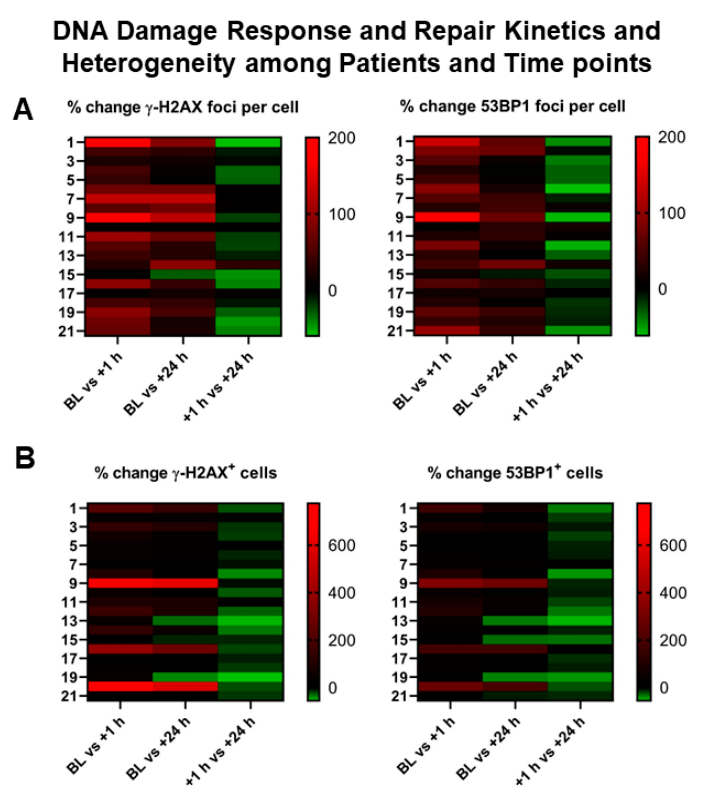
Figure 3. Heterogeneity of DNA damage response in patients receiving PRRT. ( A , B ) Graphical illustration (heat map) of inter-individual heterogeneity in DSB markers and their evolution over time, depicted as a heat map ranging from negative % change (green) to high positive % change (red) between different time points ( x -axis). Left y -axis represents patient numbers. Marked inter- individual heterogeneity can be observed in the % change both in induced DDR foci per cell (upper row) and in cells with DDR foci (lower row).